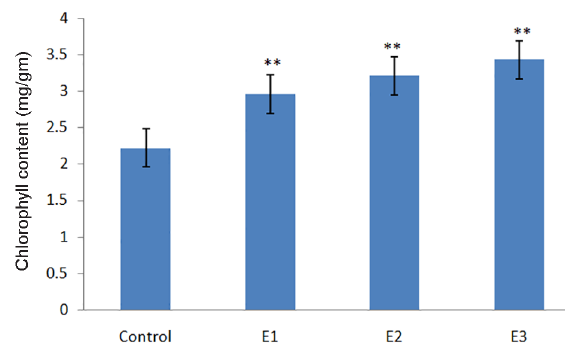
Figure 5. Change in MDA content among the experimental